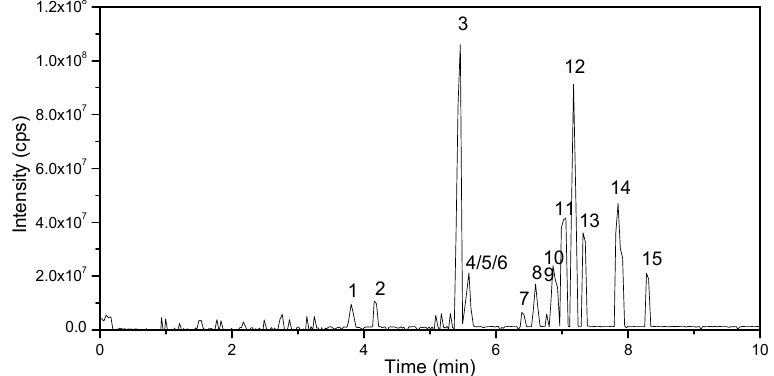
Figure 2. LC-MS/MS chromatograms of fifteen carbamate pesticides (50 ng mL −1 ).